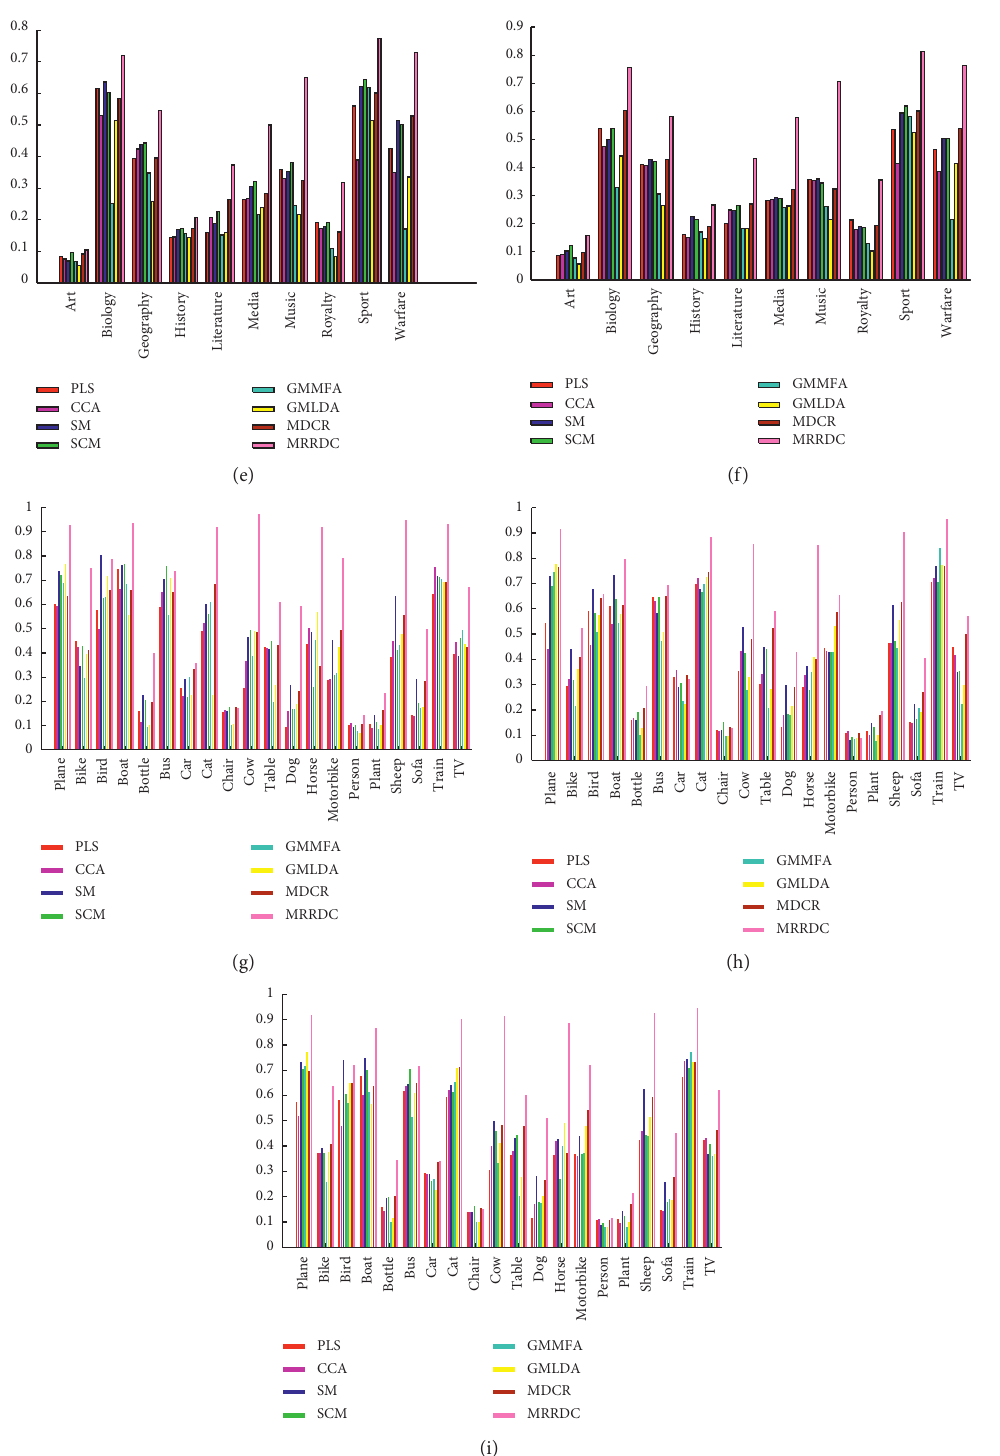
Figure 4: The mAP performance for each class on Wikipedia datasets and Pascal Sentence dataset. (a) I2Ton wiki-R. (b) T2I on wiki-R. (c) Average on wiki-R. (d) I2Ton wiki-W. (e) T2I on wiki-W. (f) Average on wiki-W. (g) I2Ton Pascal. (h) T2I on Pascal. (i) Average on